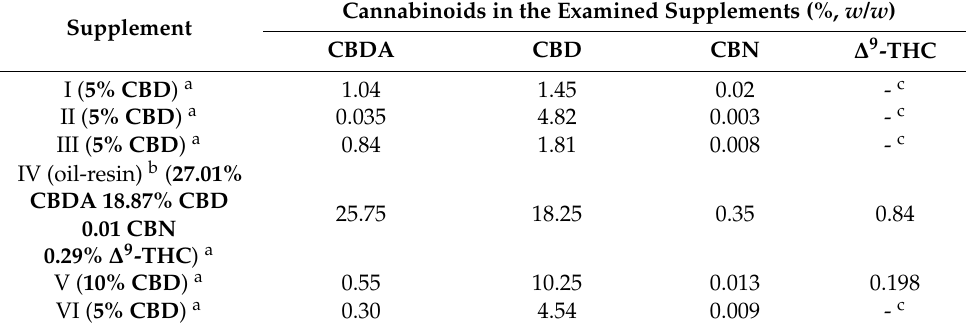
Table 4. The contents of the four cannabinoids in the analyzed supplements.